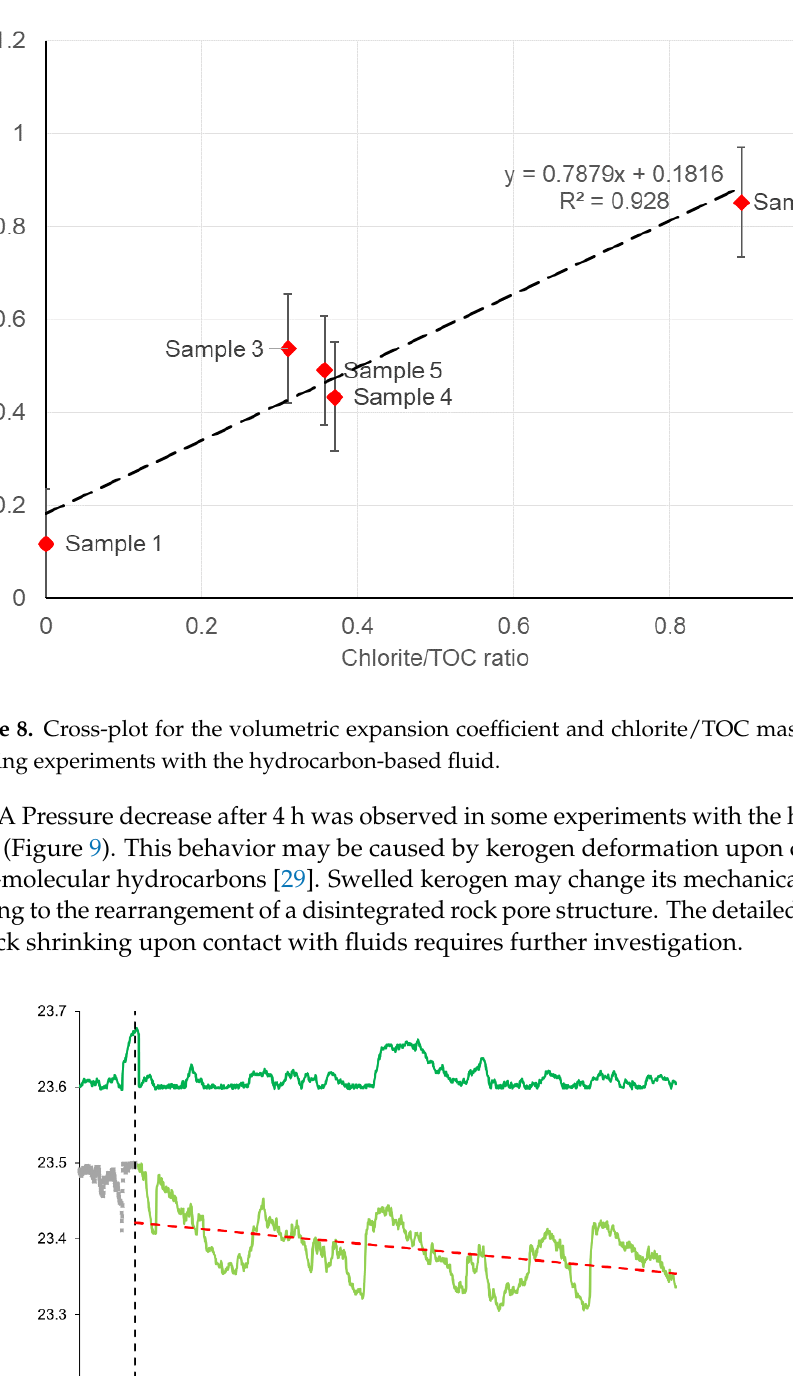
Figure 9. Pressure decrease registered after the end of the swelling period for sample 1 (indicated by the black dashed line) .